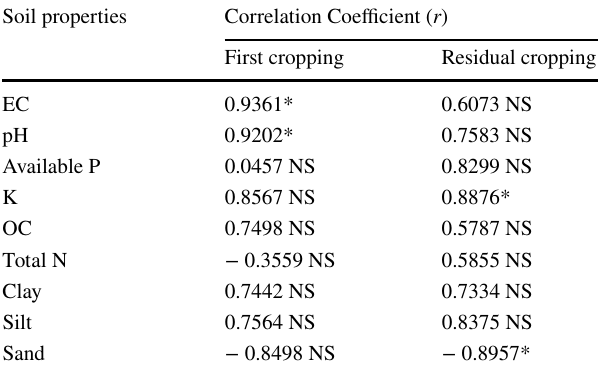
Table 5 Correlation coefficients between maize yields and soil chem- ical properties at the first and residual